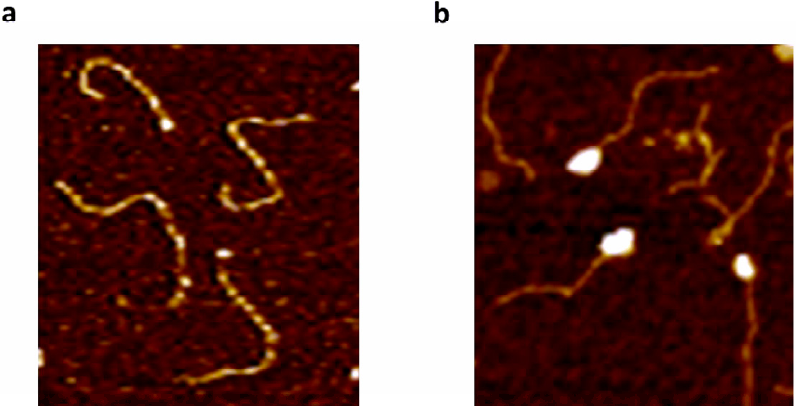
Figure 9. Structural analysis of E2 protein at HPV origin. The DNA substrate used in these studies was a PCR-amplified 1088 bp DNA fragment from the origin of replication (LCR) of the HPV11 genome. This DNA fragment is linear and 3.7 nm in length. ( a ) Linear DNA substrate of HPV origin was generated by PCR amplification of HPV-11 DNA spanning nucleotides 7076-7933/1-230. DNA containing all four E2 binding sites was visualized using AFM in the absence of E2 protein. ( b ) E2 protein bound to origin, observed as a white globule formation in AFM on the DNA.